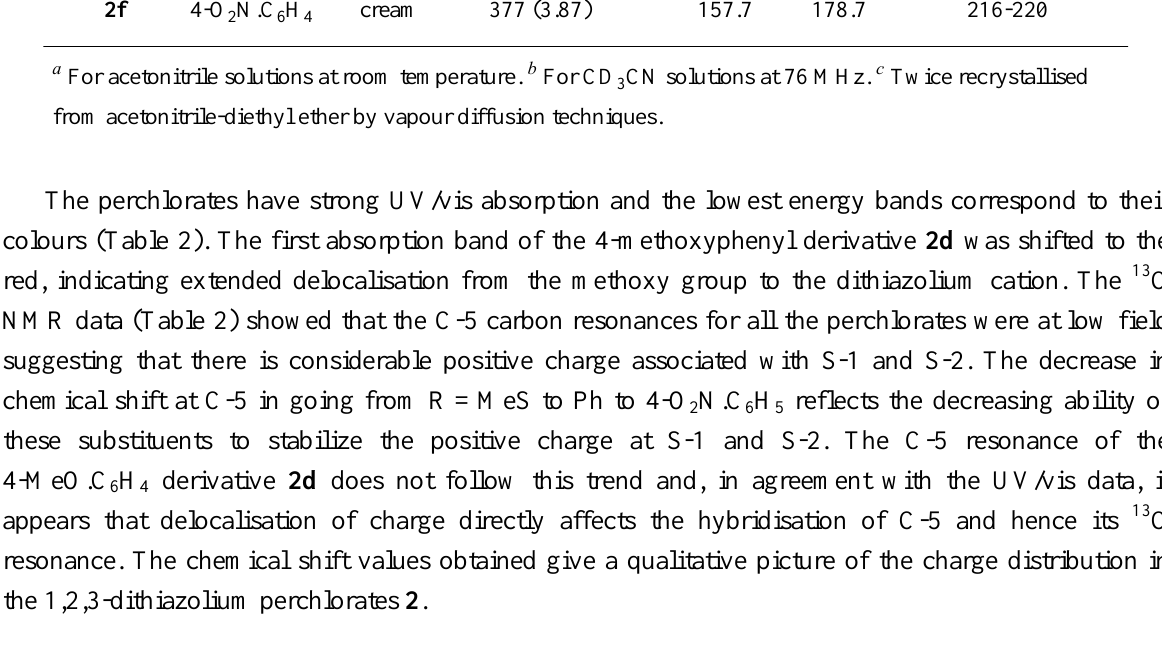
CN solutions at 76 MHz. c Twice recrystallised 3